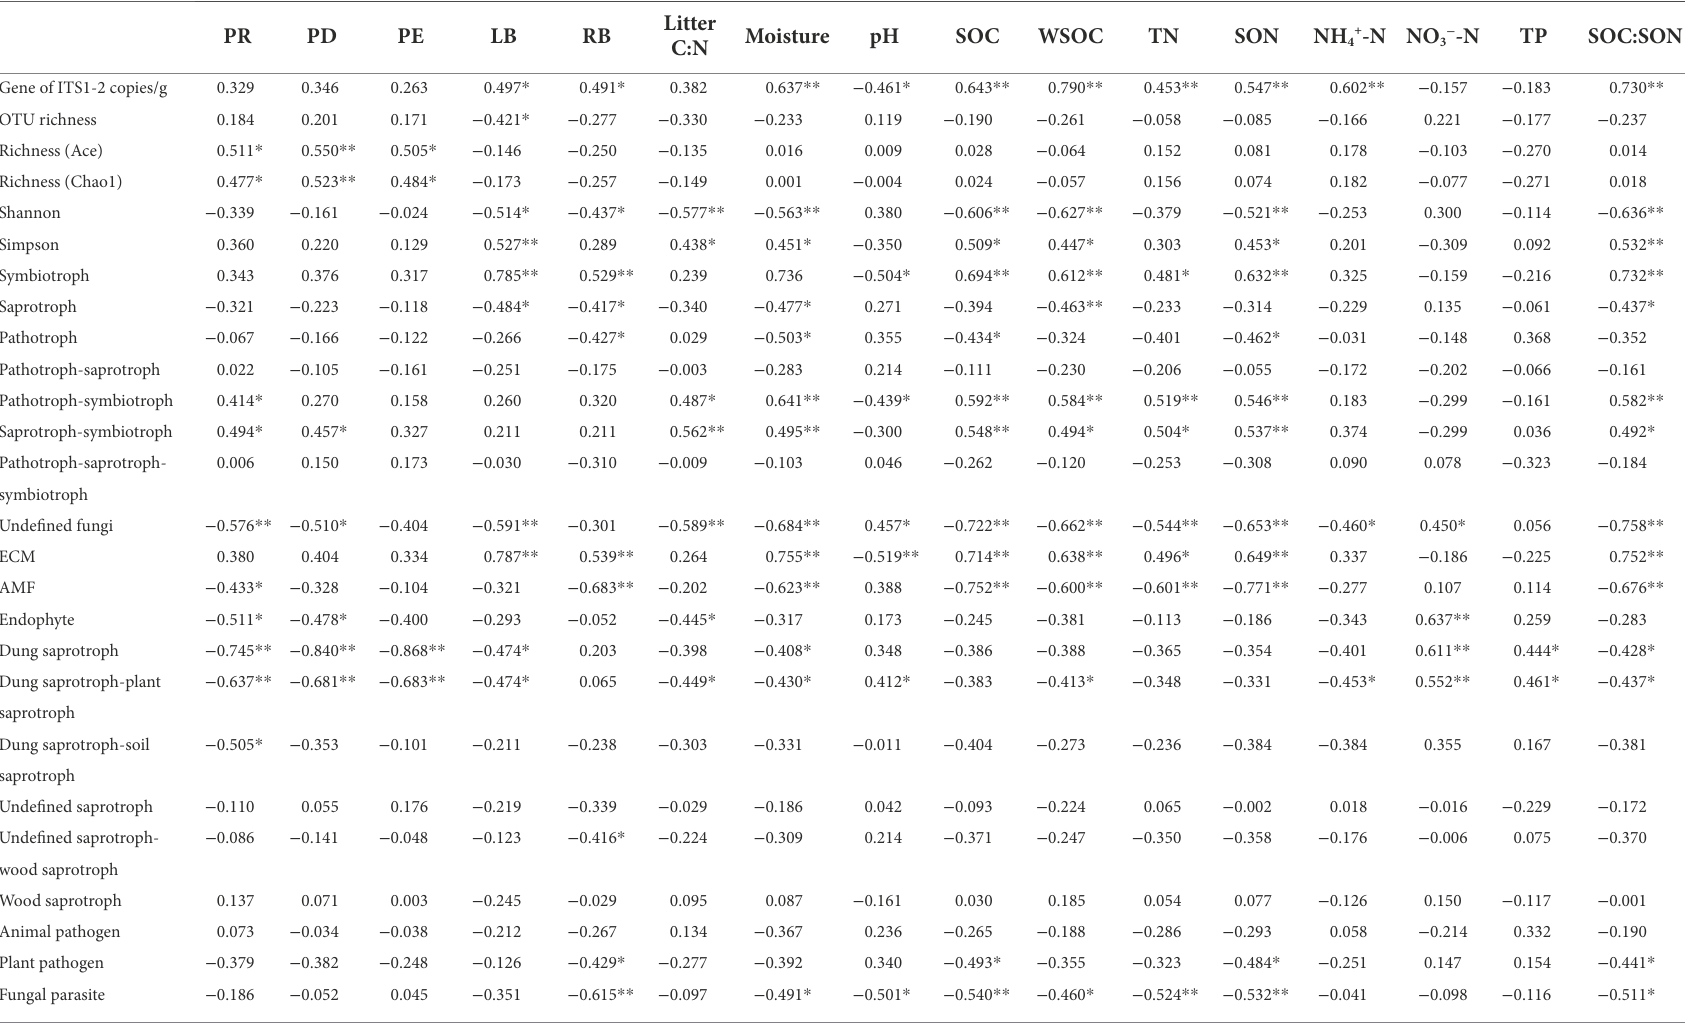
TABLE 5 Pearson correlations coefficients between fungal abundance, diversity, trophic modes, guilds and the environmental variables ( n = 4) among revegetation stages in the Loess Plateau of